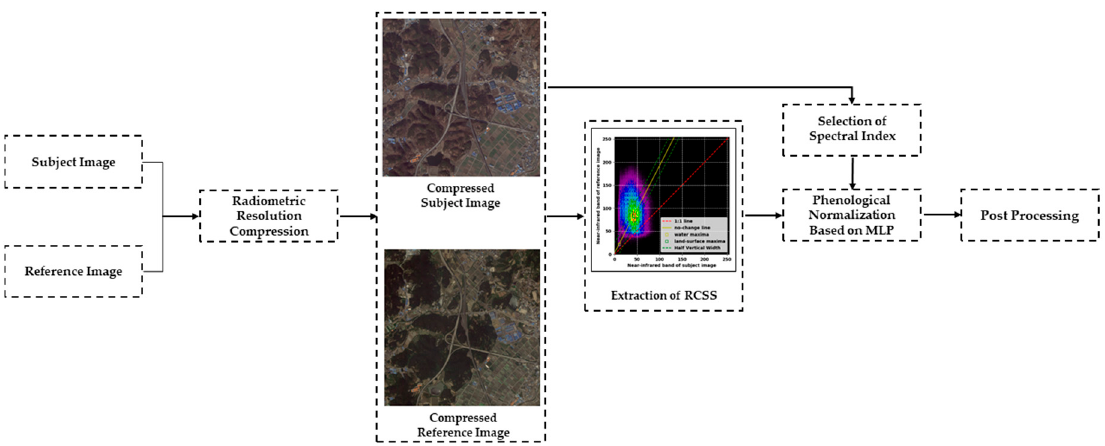
Figure 4. Flowchart of the proposed method.